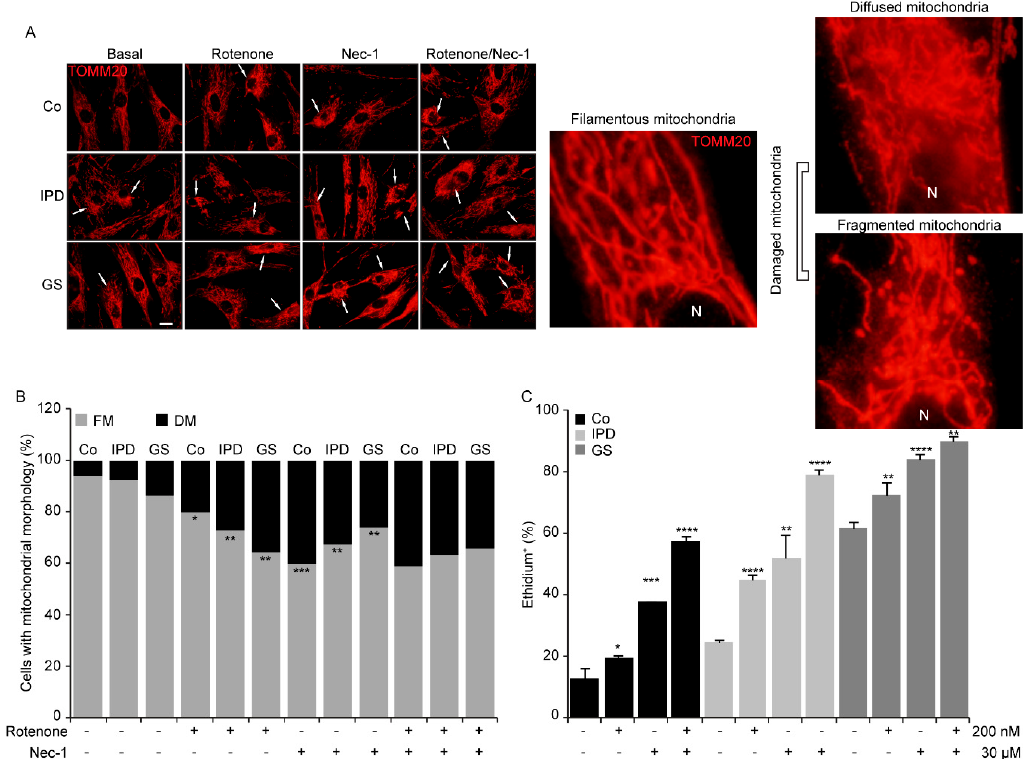
Figure 4. Necrostatin-1 alters mitochondrial morphology. ( A – C ) Human fibroblasts were treated with rotenone and/or necrostatin-1 (Nec-1) for 24 h. ( A ) Representative immunofluorescence images of cells immunolabeled with TOMM20. The scale bar represents 10 µm. The original magnification is ×40. N: nucleus. ( B ) Data are the percentages of cells with filamentous mitochondria (FM) and damaged mitochondria (DM) (* p < 0.05, ** p < 0.01, *** p < 0.001). ( C ) Fibroblasts were loaded with dihydroethidium (5 µM). The results represent the percentage ± SD of ethidium + cells detected by flow cytometry (* p < 0.05, ** p < 0.01, *** p < 0.001, **** p < 0.001, compared to basal conditions), n = 10,000 events. Experiments were done two times.